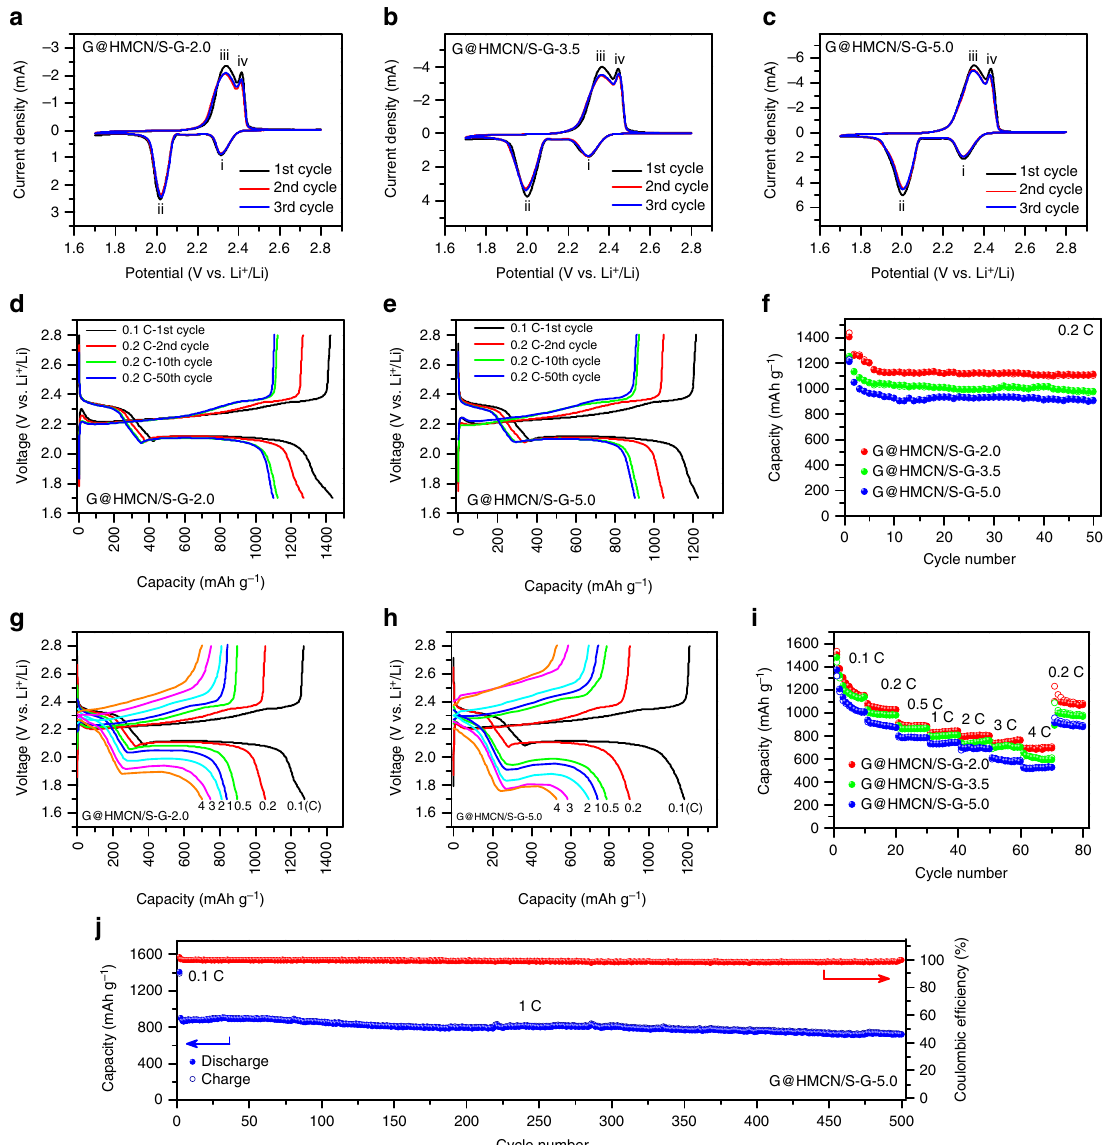
Fig. 4 Electrochemical properties of the G@HMCN/S-G cathodes. a – c CV curves of G@HMCN/S-G-2.0, G@HMCN/S-G-3.5, and G@HMCN/S-G-5.0 cycled at 0.05 mV s − 1 ; d , e Charge/discharge curves of G@HMCN/S-G-2.0 and G@HMCN/S-G-5.0 at 0.2 C; f Cycling performances of G@HMCN/S-G- 2.0, G@HMCN/S-G-3.5, and G@HMCN/S-G-5.0 at 0.2 C; g , h Charge/discharge curves of G@HMCN/S-G-2.0 and G@HMCN/S-G-5.0 at various rates; i Rate capabilities of G@HMCN/S-G-2.0, G@HMCN/S-G-3.5, and G@HMCN/S-G-5.0; j Cycling performance of G@HMCN/S-G-5.0 at 1 C. The solid